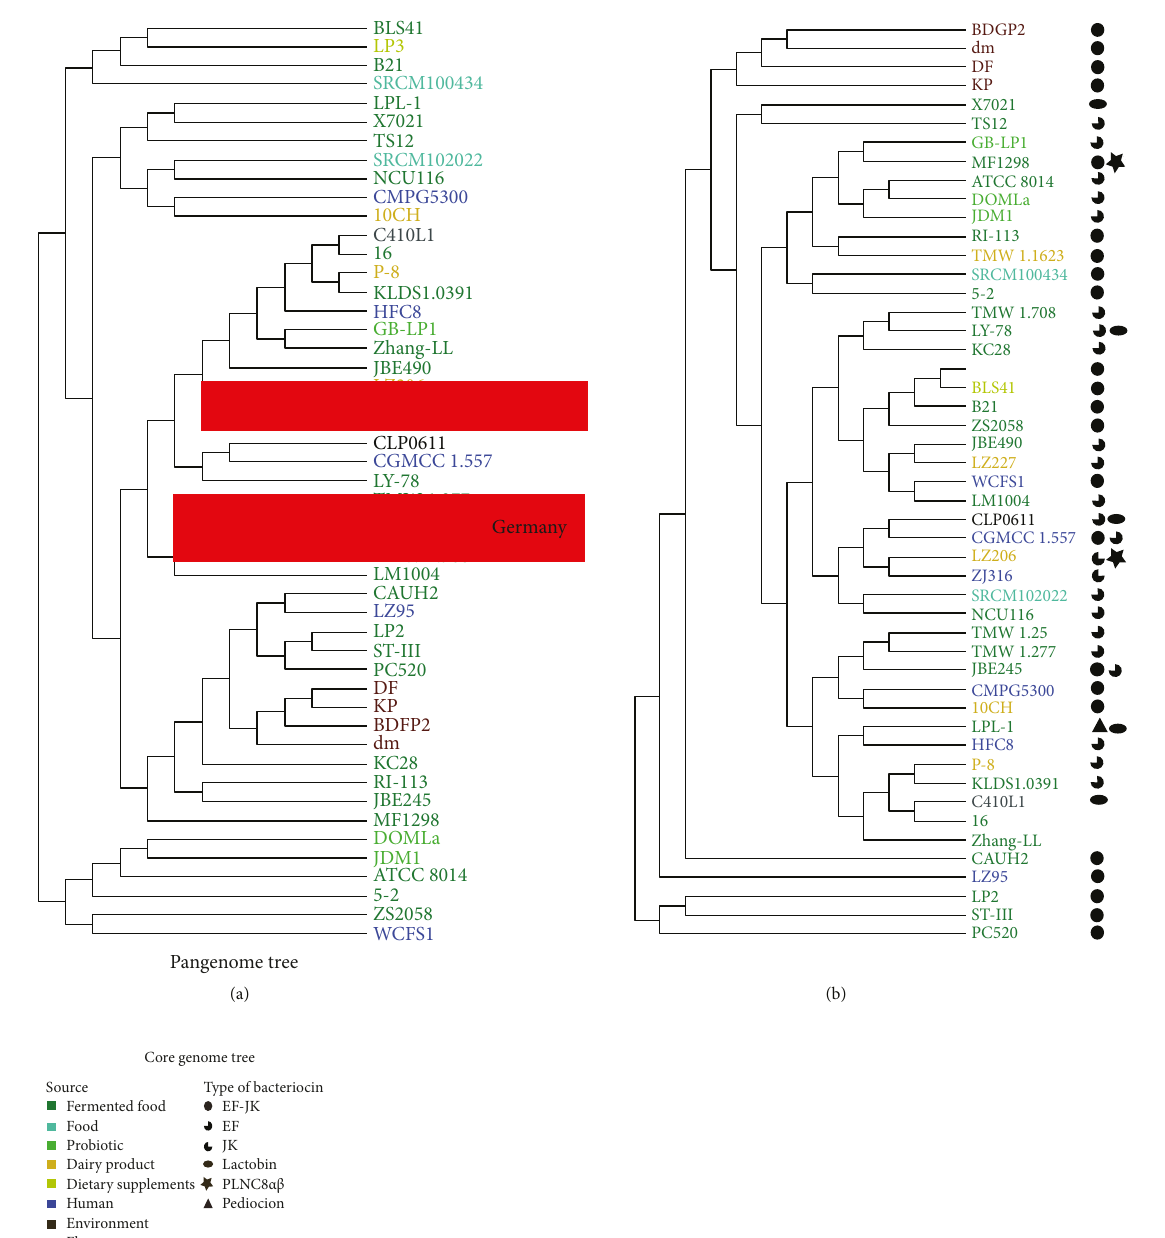
Figure 3: Phylogenies based on pangenome analyses of L. plantarum . (a) A phylogenetic tree constructed by pangenome data. The branches highlighted indicate the geographical locations where the strains were isolated. (b) A phylogenetic tree based on core genome data. The fi rst box shows which colors correspond to the source of the strains, and the box below described the symbols used here to represent the bacteriocins. The scales below the trees correspond to the time in millions of years (Mya). Nisin bacteriocin is not shown since it is present in most